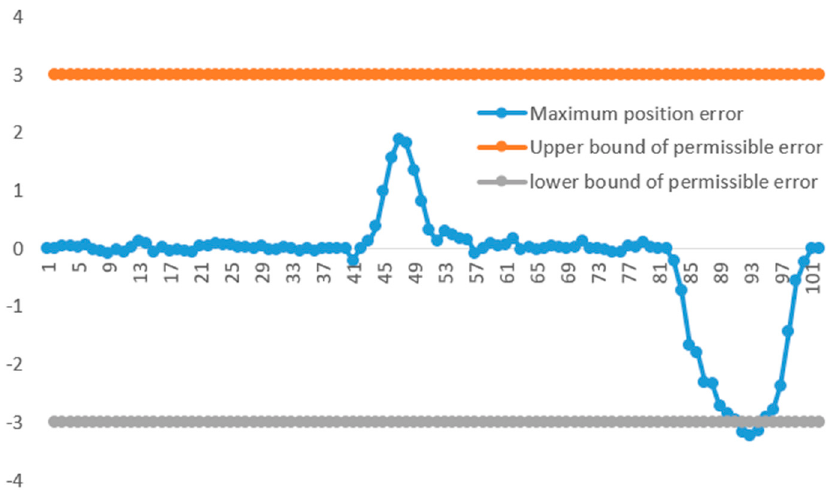
Figure 16. Position error of each trajectory point in the y ‐ direction.